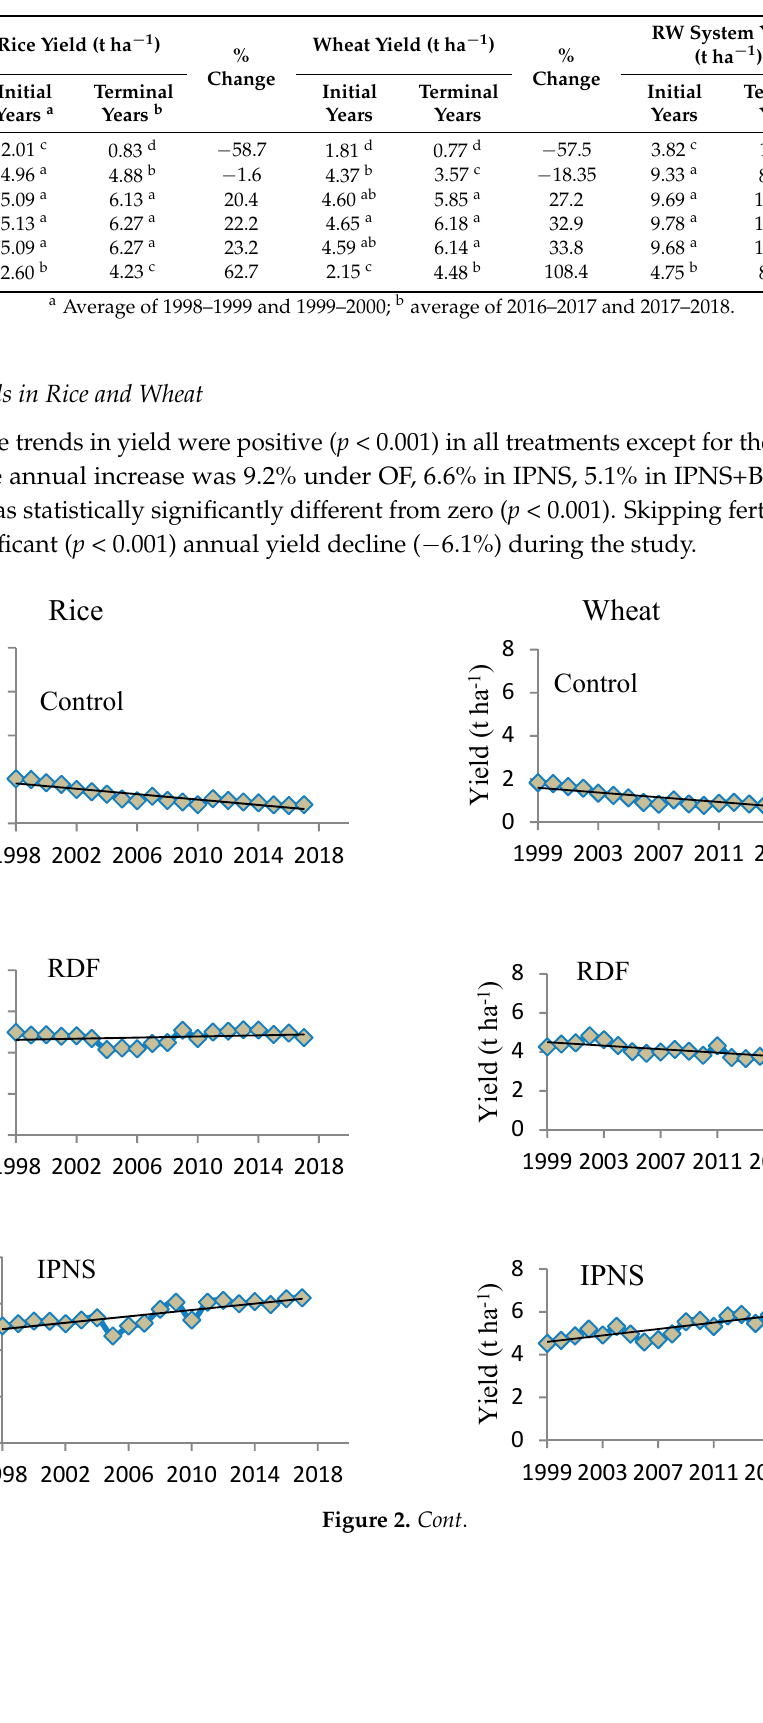
Table 4. Changes in rice, wheat and RWS productivity under different long-term nutrient management options during the initial and terminal years.